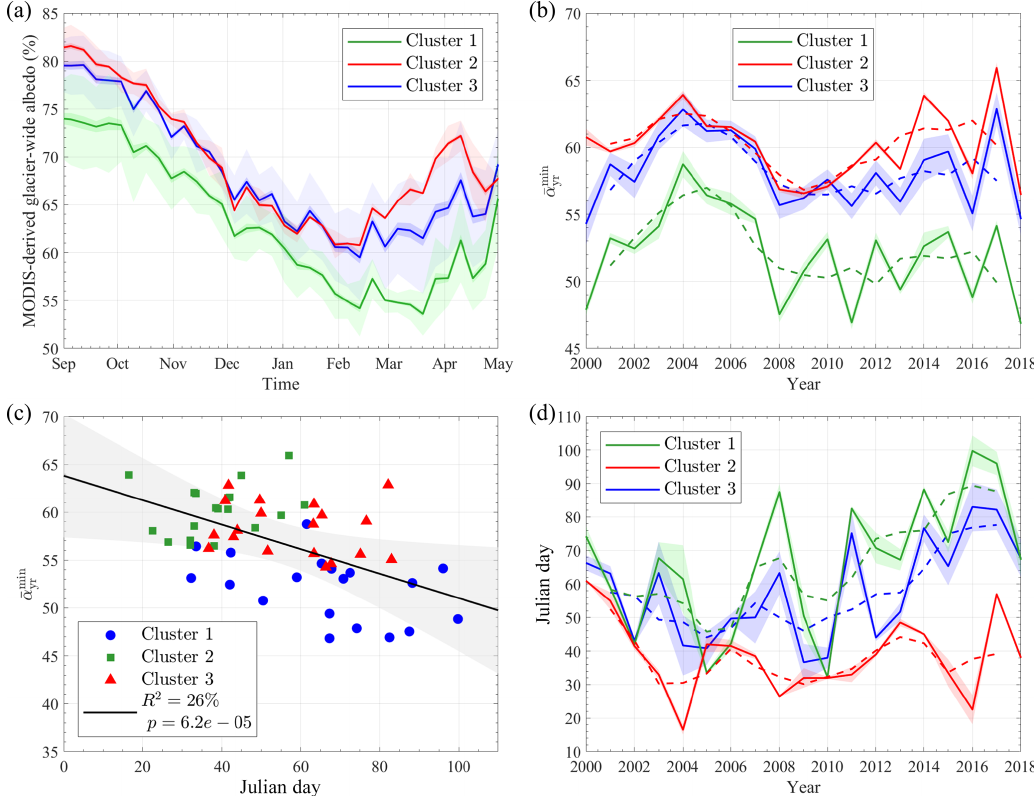
Figure 5. (a) MODIS-derived glacier-wide albedo ¯ α(t ) between September and May of the outlet glacier averaged within clusters. Values are calculated between February 2000 and April 2018 as a mean weekly average. The dark and light shaded envelopes show the standard error and standard deviation of the mean, respectively. (b) Temporal changes in ¯ α min yr averaged within clusters. (c) Correlation between ¯ α min yr and its timing in Julian days; the grey envelope shows the 95% confidence interval for the linear regression model. (d) Temporal changes in the timing of ¯ α min yr in Julian days averaged within clusters. Dotted lines show 3-year moving average.